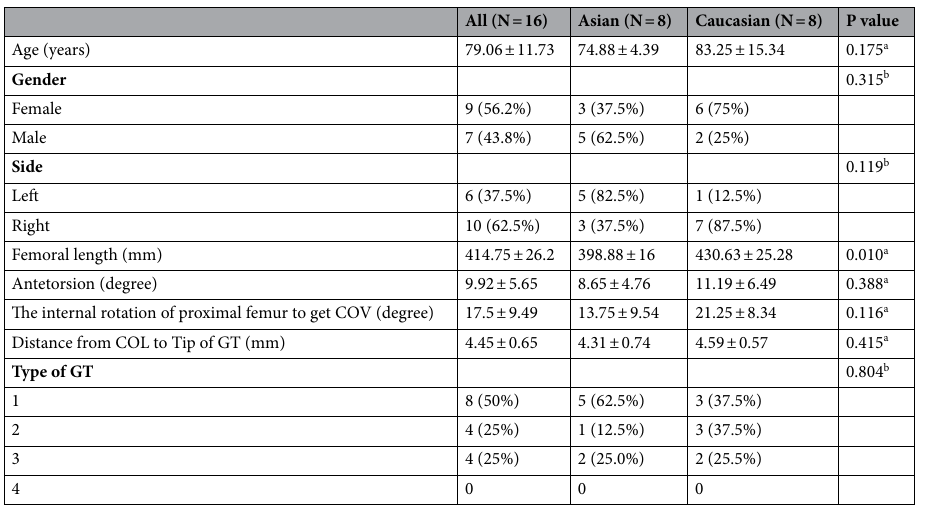
Table 1. The demographic data of all specimens (N = 16). mm millimeter, COV cortical overlap view, COL cortical overlap line, GT greater trochanter. a Independent sample t-test, b Fisher’s Exact test.